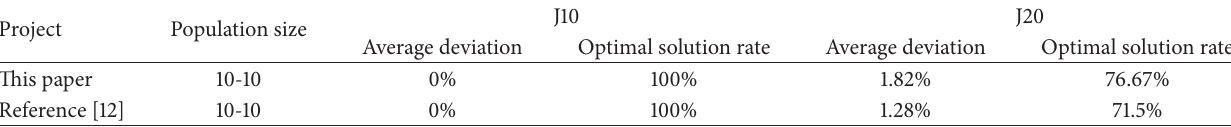
Table 3: Results comparison of the proposed algorithm and other